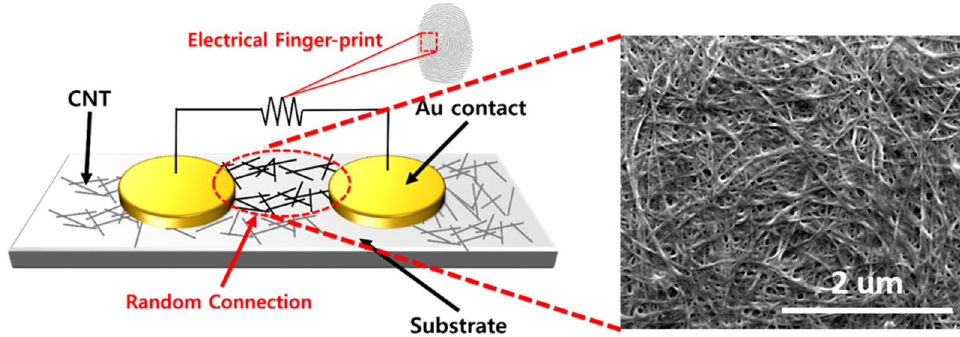
Figure 1. Schematic of M13-SWNT-based PUF. The random resistance values are attributed to the variable M13-SWNT network surfaces, which cause the unpredictable responses.